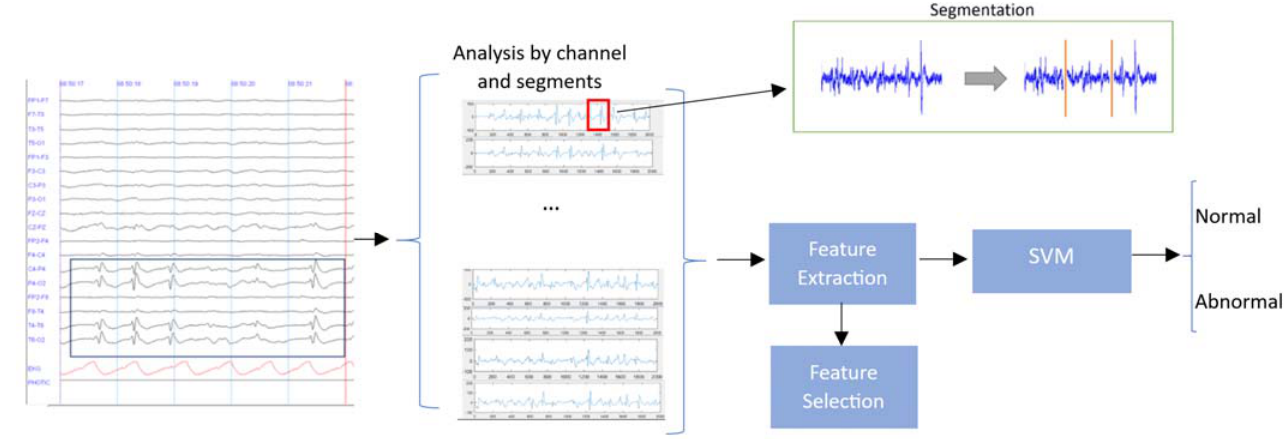
Figure 4. Scheme of detection of epileptic events.